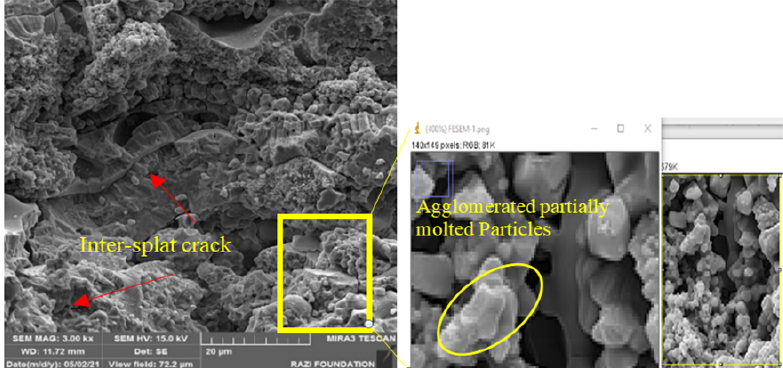
Figure 12: Fractured cross-section of nanostructured YSZ coating and non-molten nanoparticles (nanozones) within the coating at high